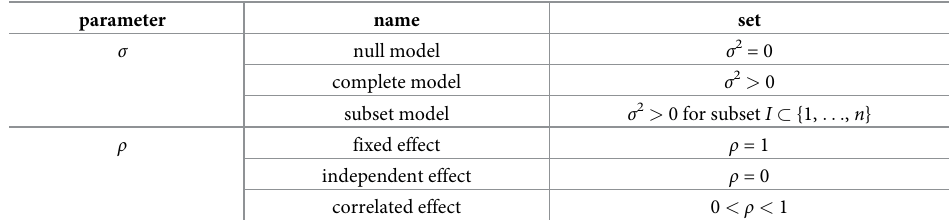
Table 1. Different models of prior across studies